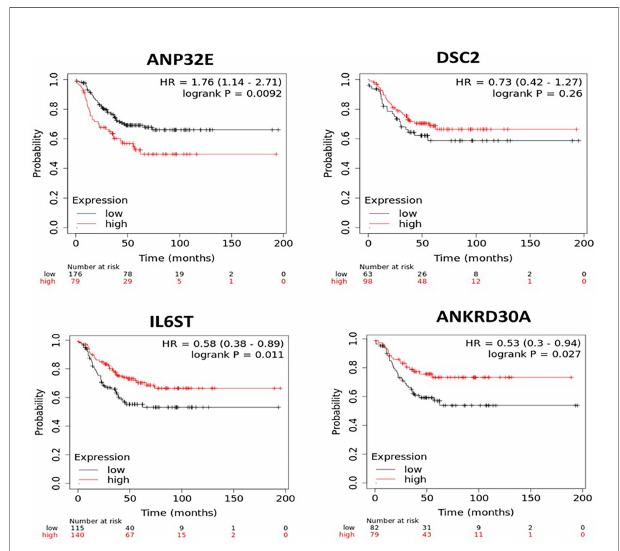
FIGURE 3 | Kaplan-Meier survival curves for patients with high or low mRNA expression of ANP32E, DSC2, IL6ST and ANKRD30A in TNBC samples. The survival analysis was performed in KM plotter using publicly available TNBC microarray data that is available within the database. TNBC samples in the KM plotter database were divided into high or low expression groups based on auto best cut-off expression value of each gene and compared by Kaplan- Meier survival analysis. A Log-rank p-value ≤ 0.05 was considered signi fi cant. HR, hazard ratio. The red curve represents high expression, and the black curve represents low expression of the indicated gene.